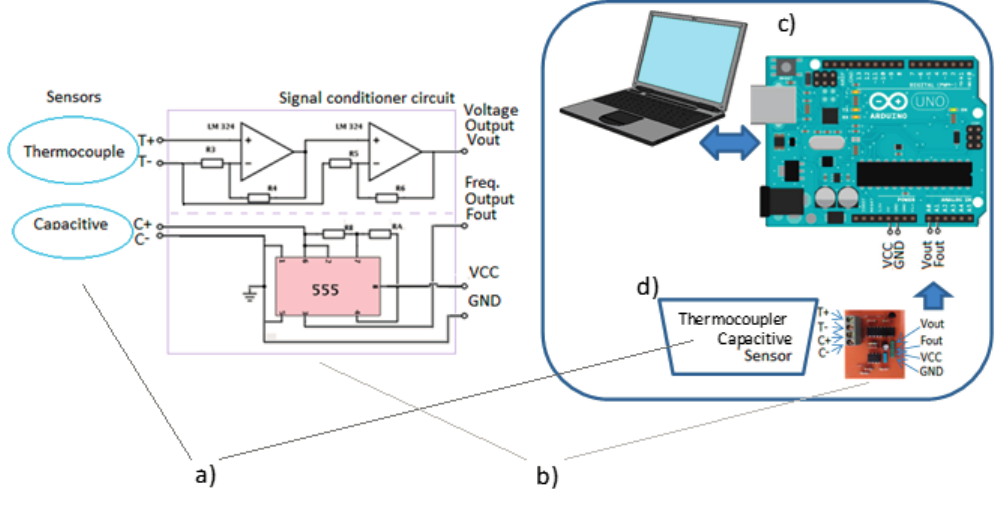
Figure 5. Data acquisition system of the sensors. ( a ) capacitive and temperature sensors; ( b ) Signal conditioner circuit; ( c ) system for storaging data; and ( d ) recipient of oil